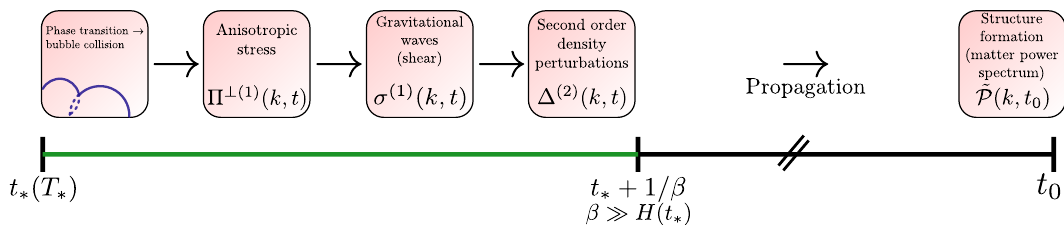
Figure 4: Timeline and schematic flow chart of the model described in the text. The green line depicts the time of the phase transition and the radiation of GWs. The flow chart on top of the line shows the processes happening during that phase on sub- horizon scales. We assume that these processes happen during the whole period of the transition. After the transition is completed, the induced perturbations affect the matter power spectrum today. The two angled lines indicate that the time between the end of the phase transition and today is much longer than the duration of the